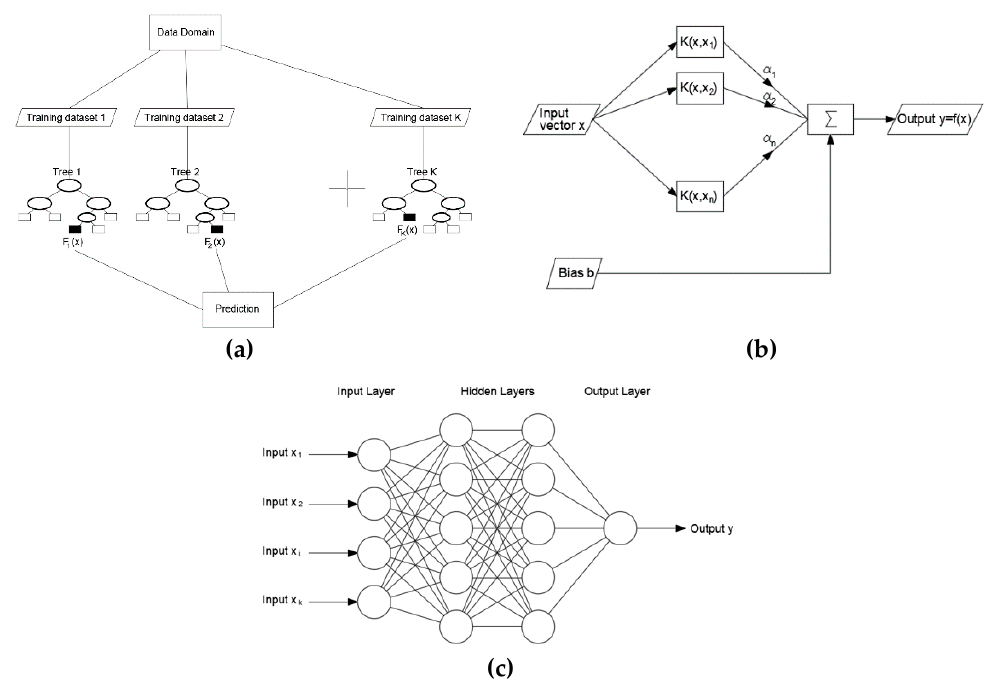
Figure 3. Typical architecture of ( a ) Random Forest, ( b ) Support Vector Regression, ( c ) Multilayer Perceptron.